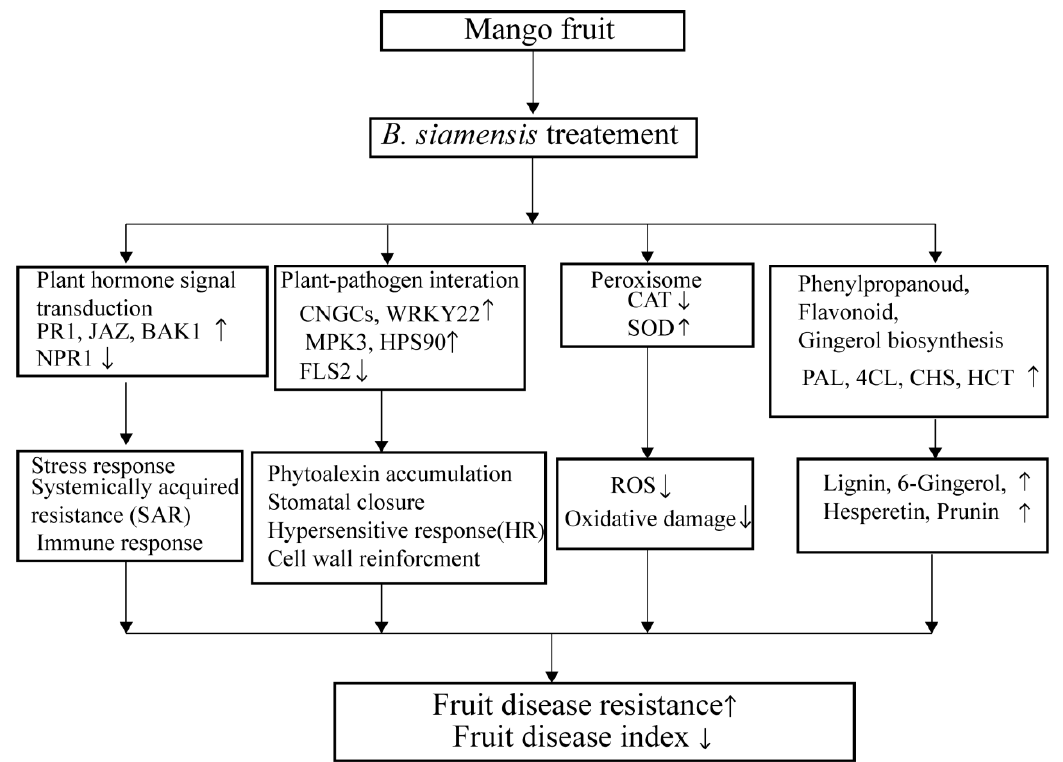
Figure 7. Mechanism diagram of mango defense response to B. siamensis . Through several branched and multi-component pathways, mangoes defense-related genes are transcribed.The up-arrow indicates the promoting effect and the down-arrow indicates the inhibiting effect.